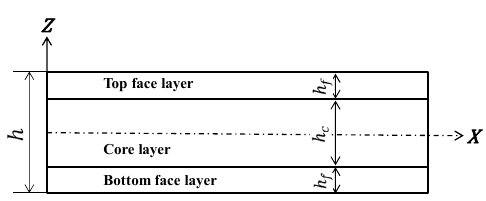
Figure 1. Schematic of a symmetric three ‐ layered beam with a soft core.